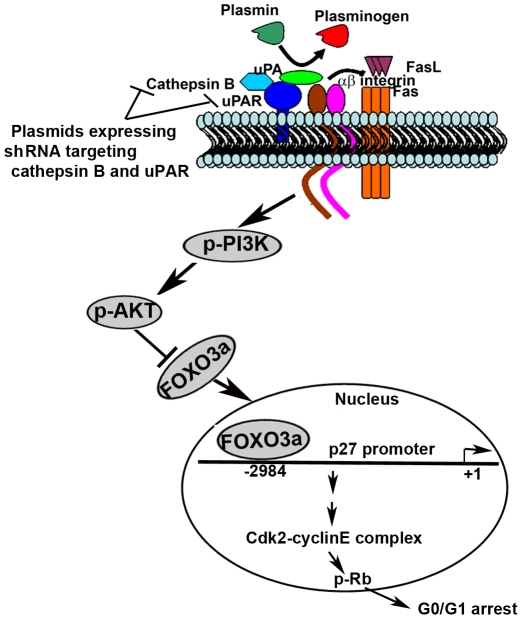
Schematic representation of the molecular mechanisms proposed in the regulation of cell proliferation by G0/G1 arrest with the increased expression of FOXO3a and p27Kip1 in cathepsin B and uPAR-depleted glioma cells.